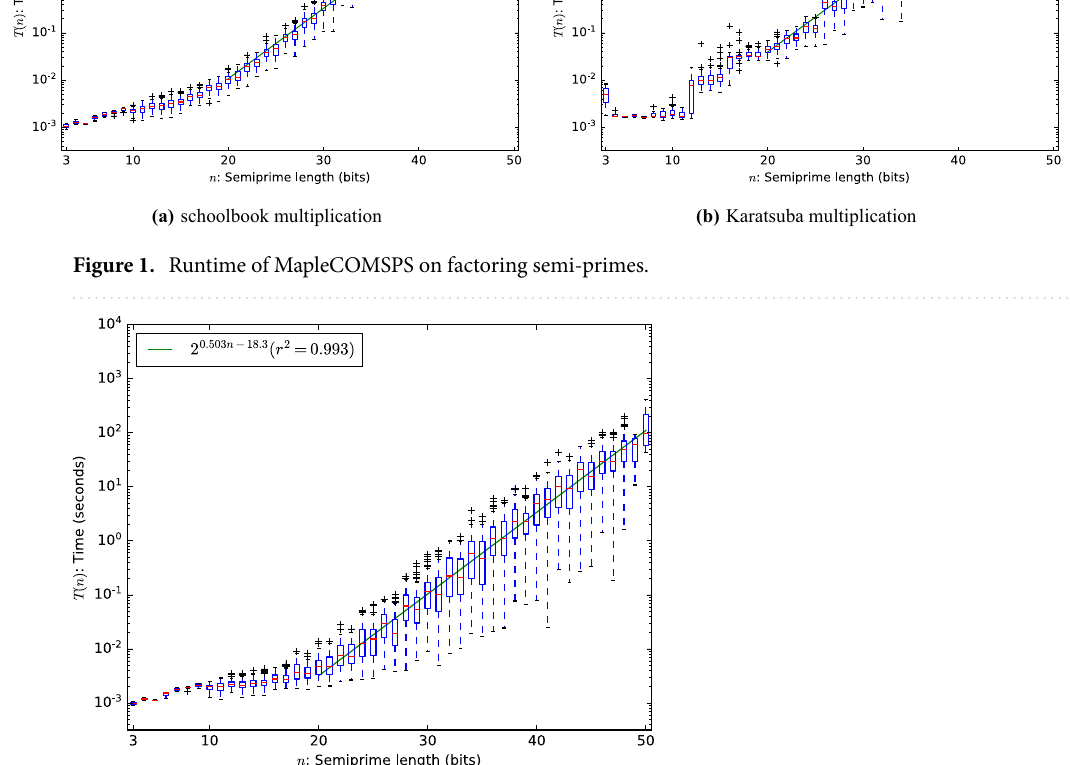
Figure 2. Minimum runtime of MapleCOMSPS on factoring semi-primes using schoolbook